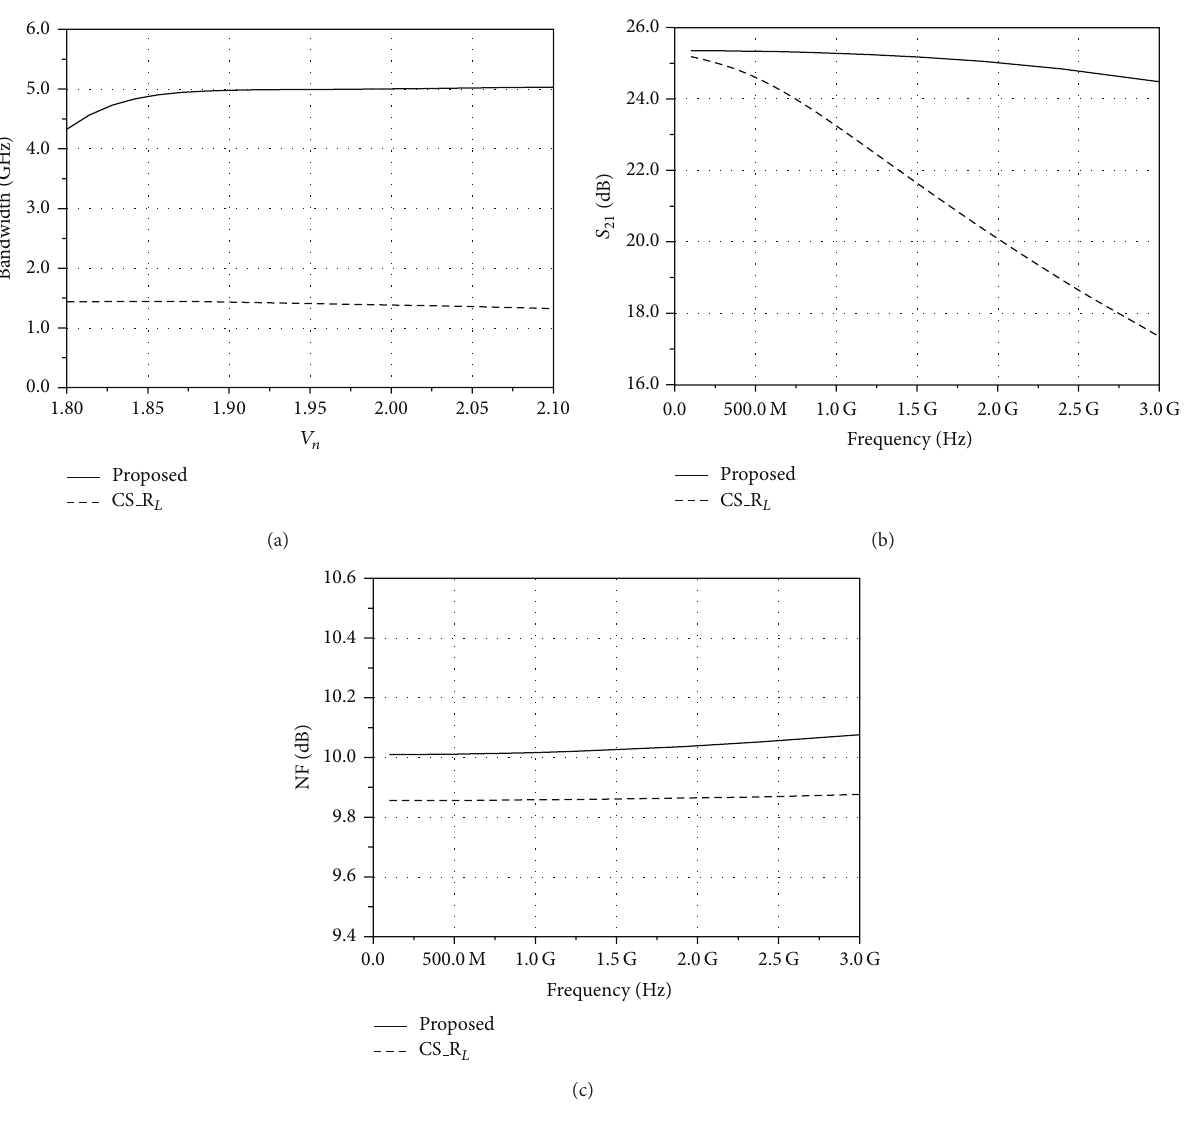
Figure 7: Comparison between proposed CH-HCS cell and CS-R